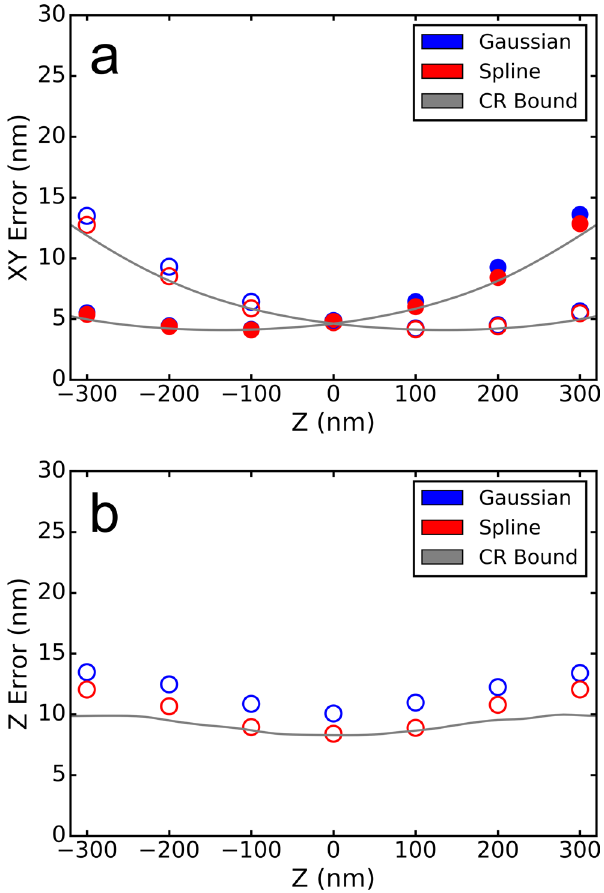
Figure 3. Astigmatic PSF fitting accuracy. ( a ) Average xy fitting error as a function of z for cubic spline versus elliptical Gaussian fitting. Ellipitical Gaussian fitting was performed with the 3D DAOSTORM algorithm that we reported previously 18 . The filled points are the error in x and the hollow points are the error in y. Each data point is the average of multiple independent z positions in the 100 nm range centered on the data point. The solid gray lines are the Cramer-Rao theoretical bounds calculated following ref. 8. ( b ) Average z fitting error as a function of z and the Cramer-Rao theoretical bound. The z fitting error and the Cramer-Rao bounds are determined as described in ( a ).